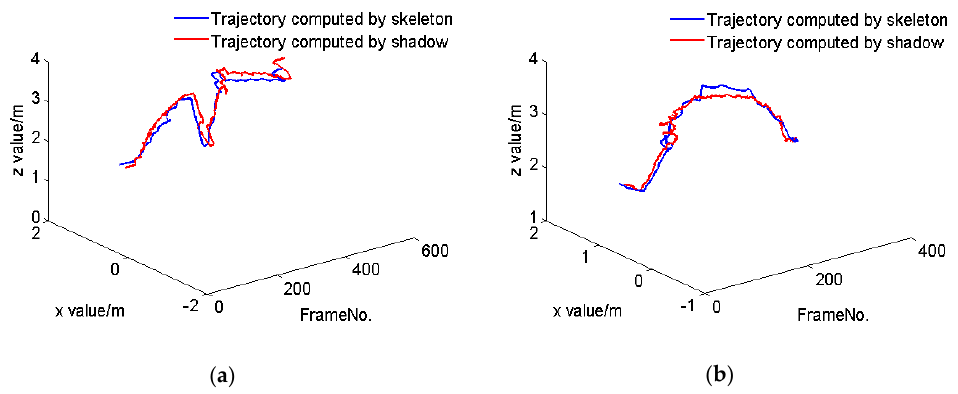
Figure 3. The tracking trajectories of one person computed using their skeleton (blue line) and shadow (red line), respectively, as the person walks along the Z direction in the coordinate system of the Kinect ( a ) at various speeds, and ( b ) at a constant speed.